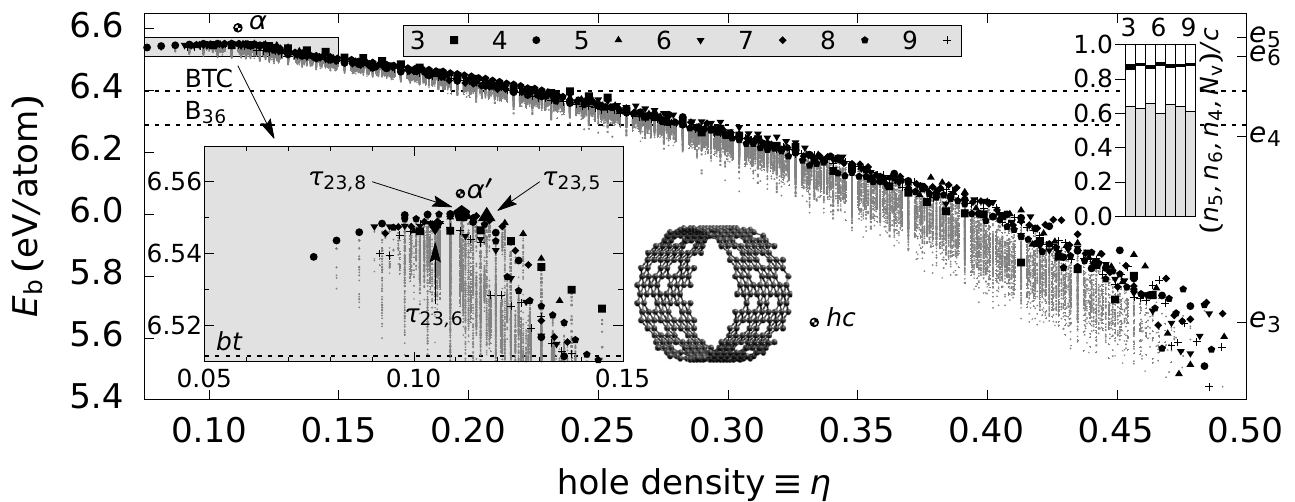
hole density η ≡ Figure 2. Binding energy per atom, E b , calculated using Equation (2) as a function of hole density, η . The data points in black correspond to BNTs with maximum values of E b obtained for a given n z parameter ( n φ = 23) and shown with a different label. The data points in gray show the full evolution and correspond to nonoptimal BNTs. The n z ∈ { 3,4, . . . ,9 } to label correspondence is provided above the data points. Shown are also data points for the hc and α sheets (with E DFT values equal to b 5.650 and 6.603 eV/atom, respectively [30]), as well as energy levels (dotted lines) associated with the BTC and B 36 structures (with E DFT values equal to 6.397 and 6.288 eV/atom, respectively [30]). The b inset on the left (with gray background) shows an enlarged view of a fragment of the main picture. The data point labeled as α (cid:48) corresponds to the α -sheet with E b = 6.557eV/atom calculated using = 6.512eV/atom [30] of the bt -sheet is also Equation (2). The energy level corresponding to E DFT b shown. The histogram on the right presents (from bottom) the values of n 5 / c (gray), n 6 / c (white), n 4 / c (black), and N v / c (white) for τ 23, n nanotubes. In the center, the unit cell of the τ 23,8 nanotube z is